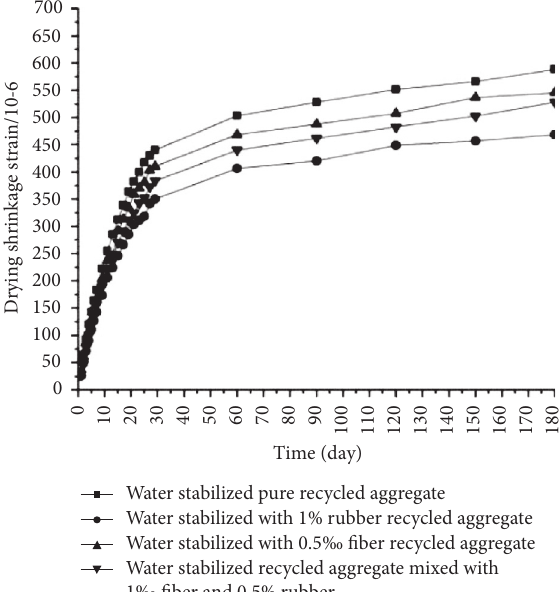
Figure 17: Comparison diagram of dry shrinkage test results.